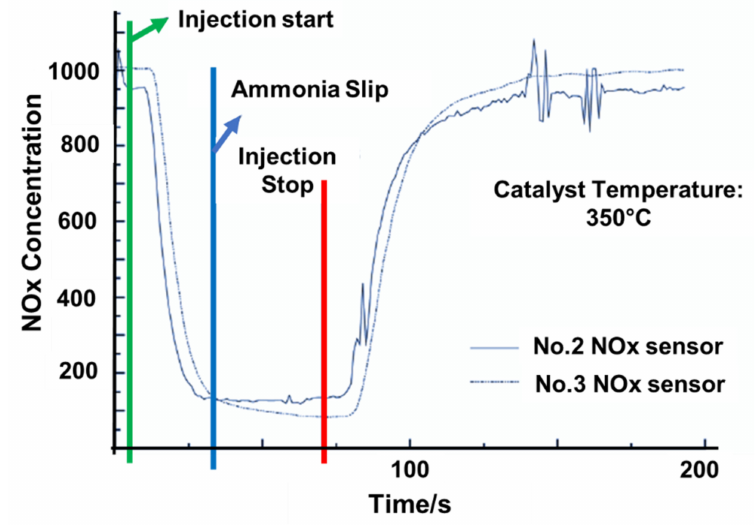
Figure 6. The mechanism of adjusting the NOx concentration downstream of the SCR catalyst, adapted from Tang et al. [63].